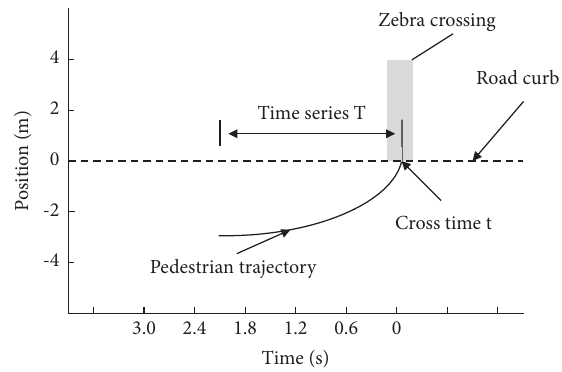
Figure 7: Time-series schematic diagram before pedestrians cross the zebra crossing: the dotted line is the curb, and the gray box is the zebra crossing. Time series T refers to the time from the beginning of the pedestrian trajectory to the time when pedestrians arrive at the zebra